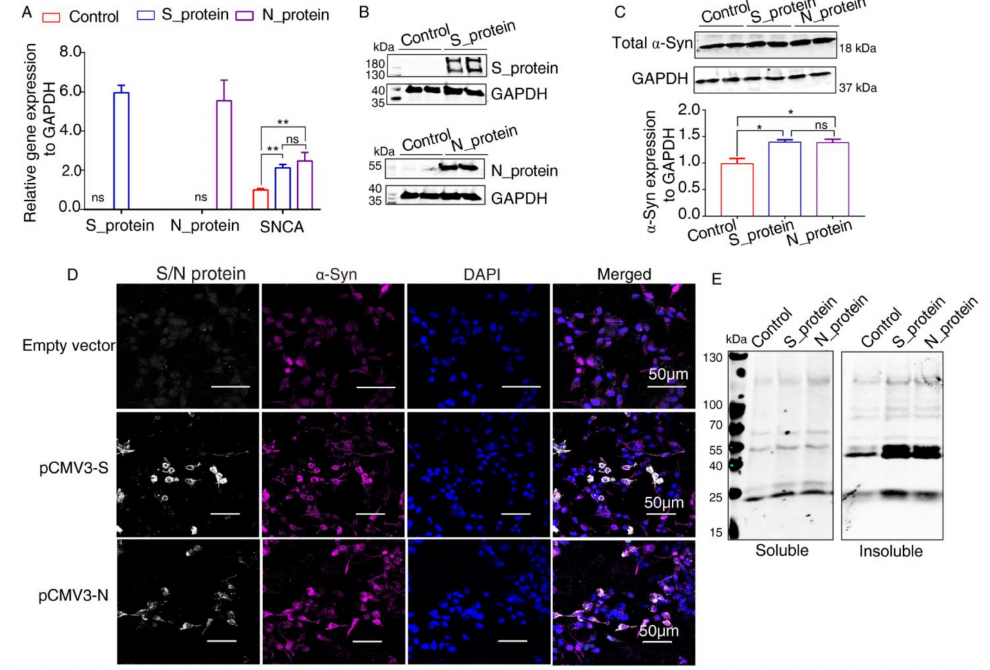
Figure 3. Elevated expression of α -Syn by SARS-CoV-2 proteins in HEK293 cells. ( A ) qRT-PCR analysis of the expression of α -Syn in HEK293 cells overexpressing S and N proteins. GAPDH was used as a loading control ( n = 3). ( B ) Two days following transfection with pCMV3-S or pCMV3-N plasmids, the total protein from the HKE293 cells was extracted and detected by anti-SARS-CoV-2 S protein and anti-SARS-CoV-2 N protein. ( C ) Immunoblotting was performed using Syn1, an antibody that recognizes total α -Syn. GAPDH was used as a loading control. ( D ) The cells transfected with plasmids pCMV3-S or pCMV3-N for 48 h were fixed with paraformaldehyde containing 0.1% Triton X-100. Then, anti- α -Syn was detected by indirect immunofluorescence. DAPI was used to stain nuclei. ( E ) Western blotting detected “soluble” and “insoluble” fraction with an antibody against α -Syn (Syn1). p value represents results of One-way ANOVA. * p < 0.05; ** p < 0.01. “ns” means no significant